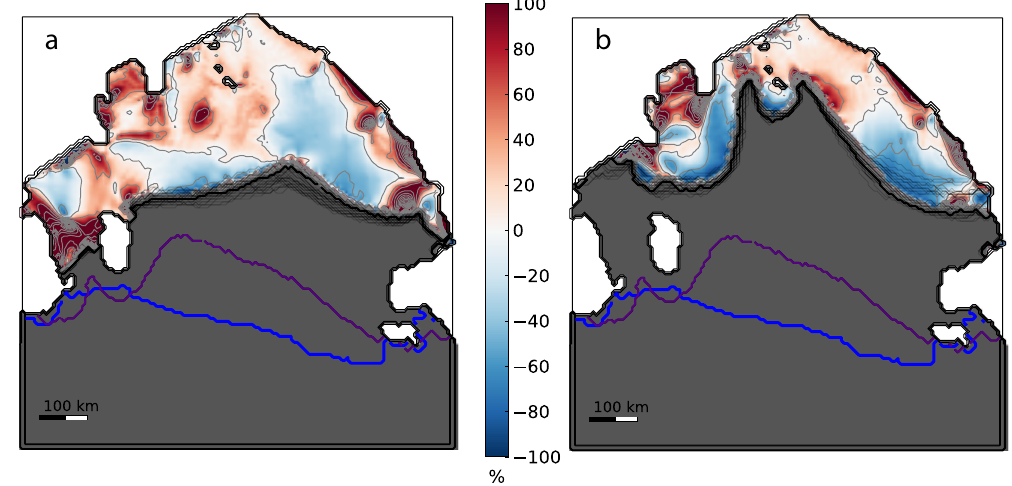
Fig. 9. Additional stable calving front of the Ross Ice Shelf under eigencalving . Colors represent relative change in longitudinal stress between the modeled presently observed extent of the ice shelf (thick blue line) and the second and third stable states of the ice shelf. Gray lines adjacent to the calving front represents the variability of the front in the equilibrium simulation. Panel a: State with 37% reduced ice shelf area. Panel b: State with 60% reduced ice shelf area compared to the modeled present-day situation. Back stress onto the West Antarctic Ice Sheet in these states is reduced by up to